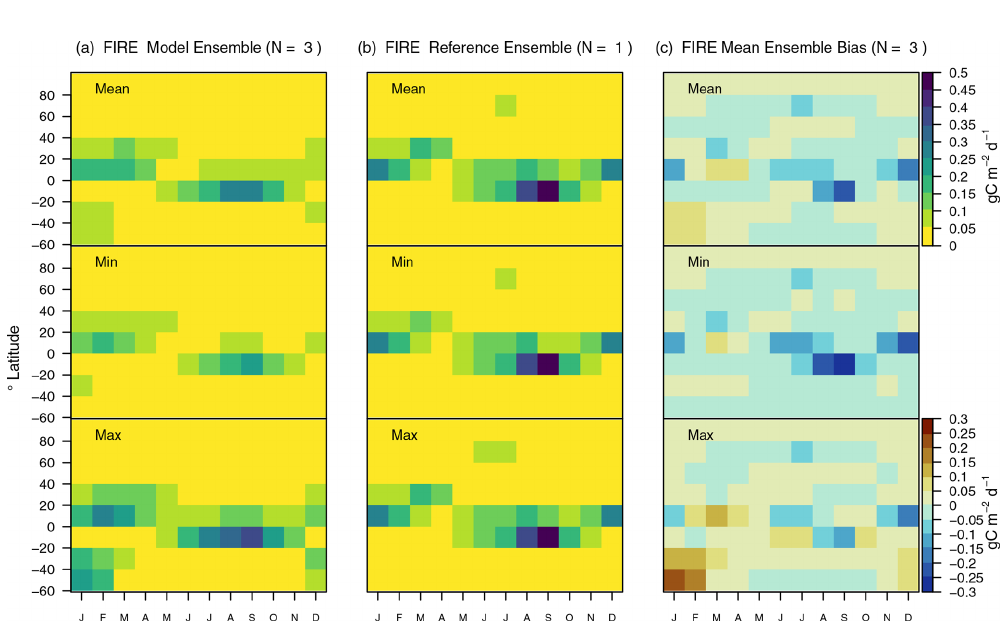
Figure A21. Same as in Fig. 8 but for emissions from wildfires.